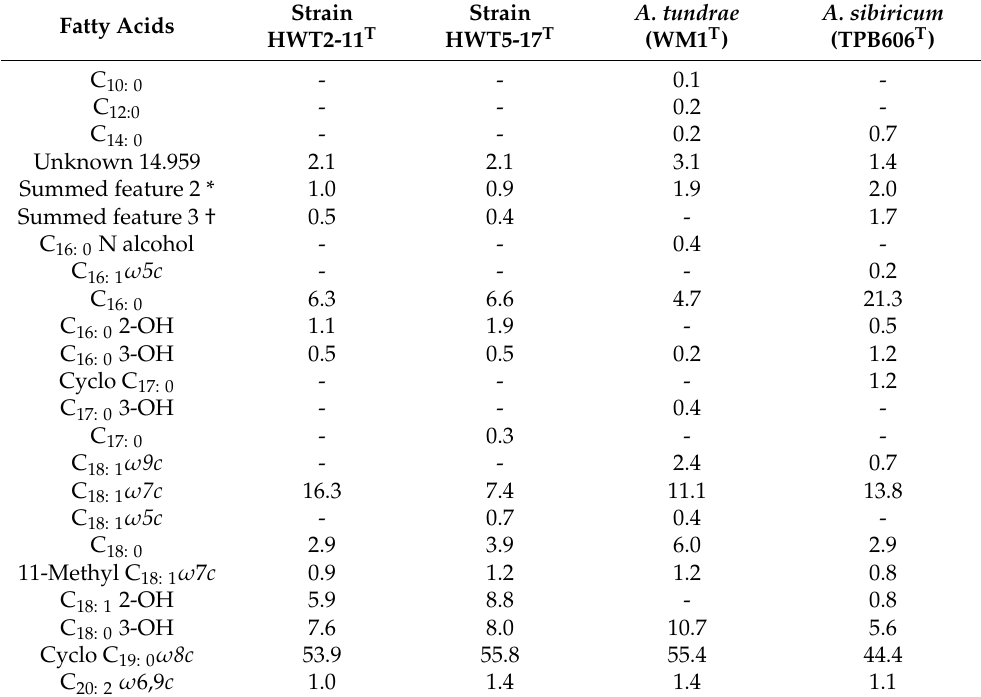
Table 2. Whole-cell fatty acid profiles (% of the total) of strains HW T2.11 T ( Acidisoma silvae ), HW T5.17 T ( A. cellulosilytica ) and previously described type strains of A. tundrae (WM1 T ) and A. sibiricum (TPB606 T ). Values are percentages of the fatty acids that were assigned to fatty acids in the peak- naming table of the MIS database (MIDI, Microbial ID, Newark, DE 19711 U.S.A.). The nomenclature is as follow: the first number indicates the number of carbon atoms in the molecule; ‘iso’, ‘OH’, ‘methyl’ and ‘cyclo’ indicate isobranched, hydroxy, methylated or cyclic fatty acids; the second number following the colon indicates the number of double bonds present. The position of the double bond is indicated by the carbon atom position starting from the methyl ( ω ) end of the molecule. c , cis isomer. Major fatty acids are indicated in bold.